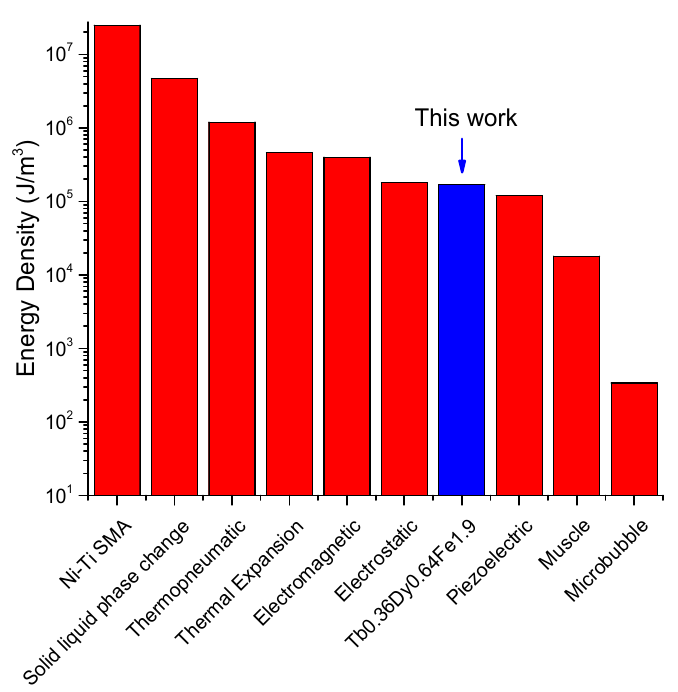
Figure 12. Comparison of energy densities for Tb 0.36 Dy 0.64 Fe 1.9 and another types of actuators [40].